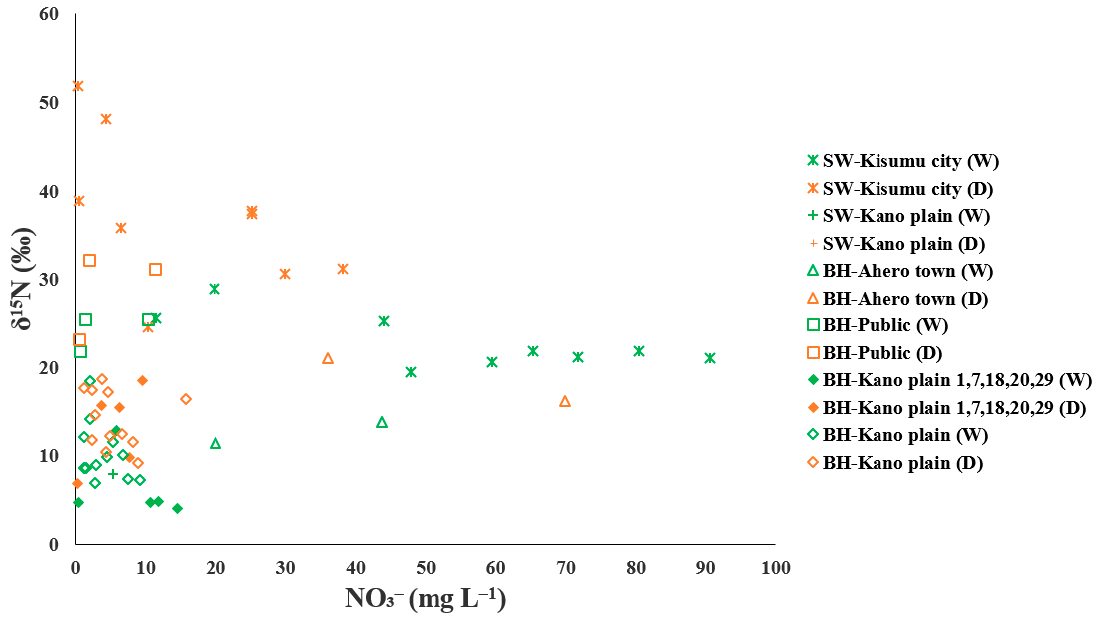
Figure 5. NO 3 − concentrations vs. δ 15 N-NO 3 − of groundwater samples categorized as, SW-Kisumu city: shallow wells located in Kisumu city; SW-Kano plain: shallow wells in Kano plain; BH-Ahero town: boreholes in Ahero town; BH-Public: boreholes in public institutions located in populated neighborhoods; BH-Kano plain: boreholes in Kano plain; and BH-Kano plain 1, 7, 18, 20, and 29: boreholes in Kano plain showing NO 3 − decrease with δ 15 N-NO 3 − increase, during wet (green symbols) and dry (brown symbols) seasons.